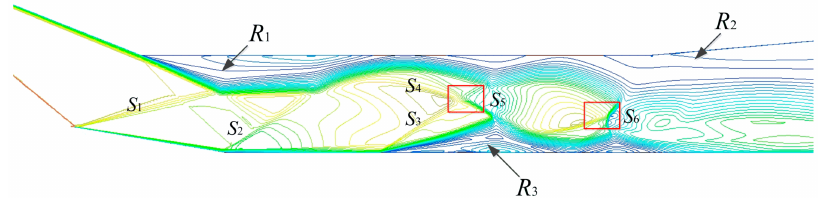
Figure 15. Mach number Isolines of Model A at t = 12